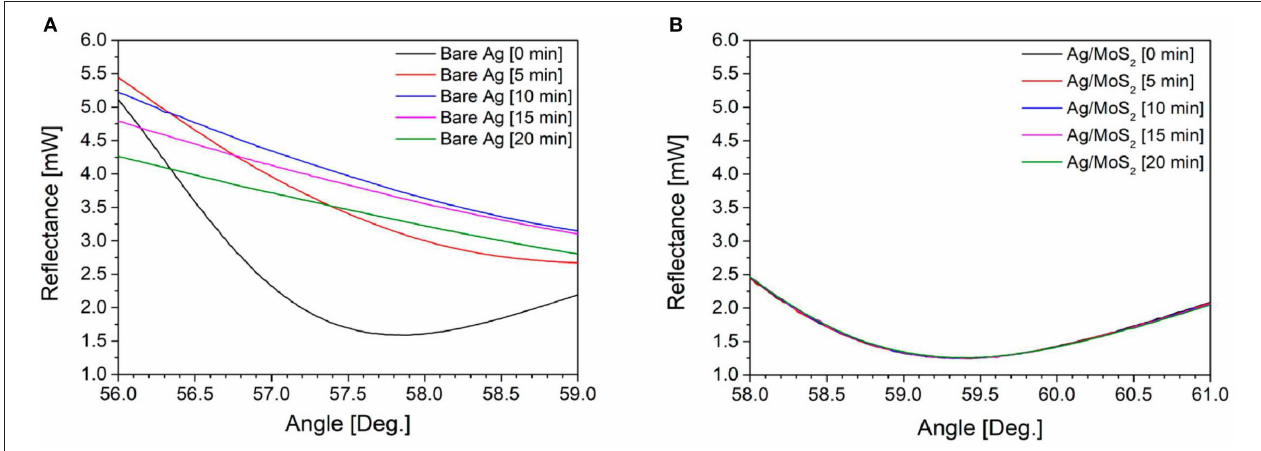
FIGURE 12 | Surface plasmon resonance signals of (A) bare Ag and (B) Ag/MoS 2 chip in water with laser irradiation. Figures (A,B) were reproduced from Kim et al. (2019) with permission from MDPI.